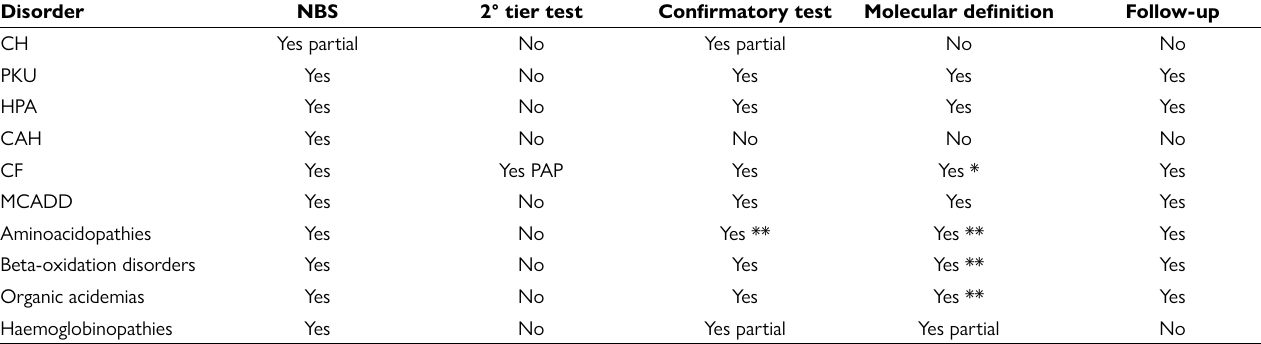
Table 4. Development of the benefits provided in the BPS for each disorder or group of